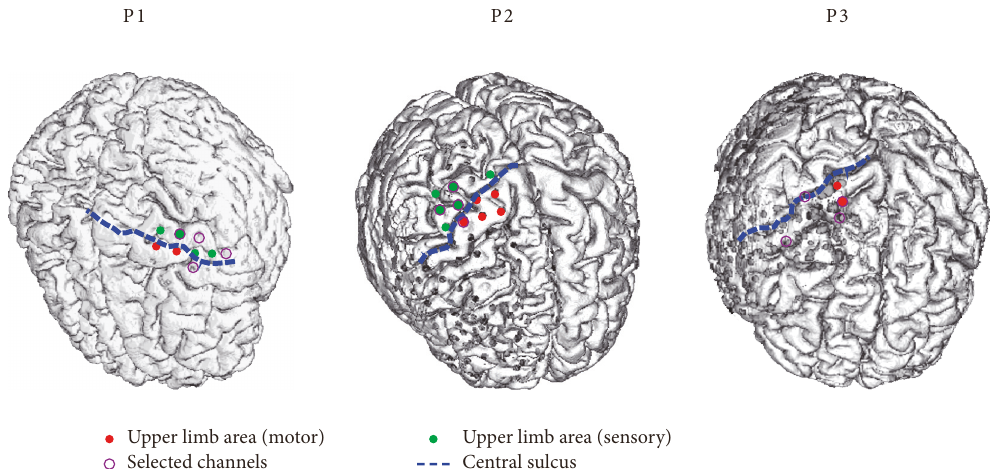
Figure 3: The locations of the subdural ECoG electrodes and their results of cortical electrical stimulation. Red dots indicate the locations of electrodes over primary motor cortex. Green dots indicate the locations of upper limb areas over primary sensory cortex. Purple circles represent the channels selected by greedy algorithm (see Channel Selections and Anatomical Patterns). Blue dash lines mark the central